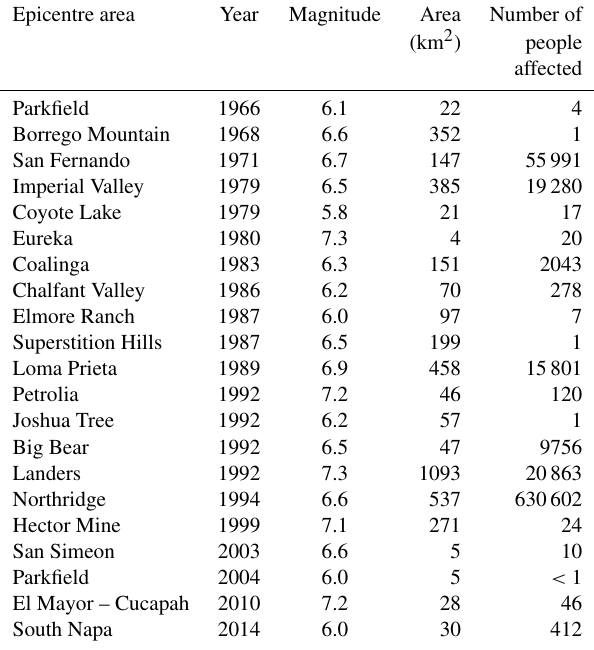
Table 5. Earthquakes that have occurred in California since 1950 with a maximum macroseismic intensity on the modified Mercalli scale (MMI) modelled by the ShakeMap programme (US Geologi- cal Survey) above or equal to VIII. The columns “area” and “num- ber of people affected” give the size and the estimated population of the area affected above or equal to VIII, respectively. The popu- lation has been assessed using the Global Human Settlement Popu- lation Grid (European Commission, Florczyk et al., 2019).